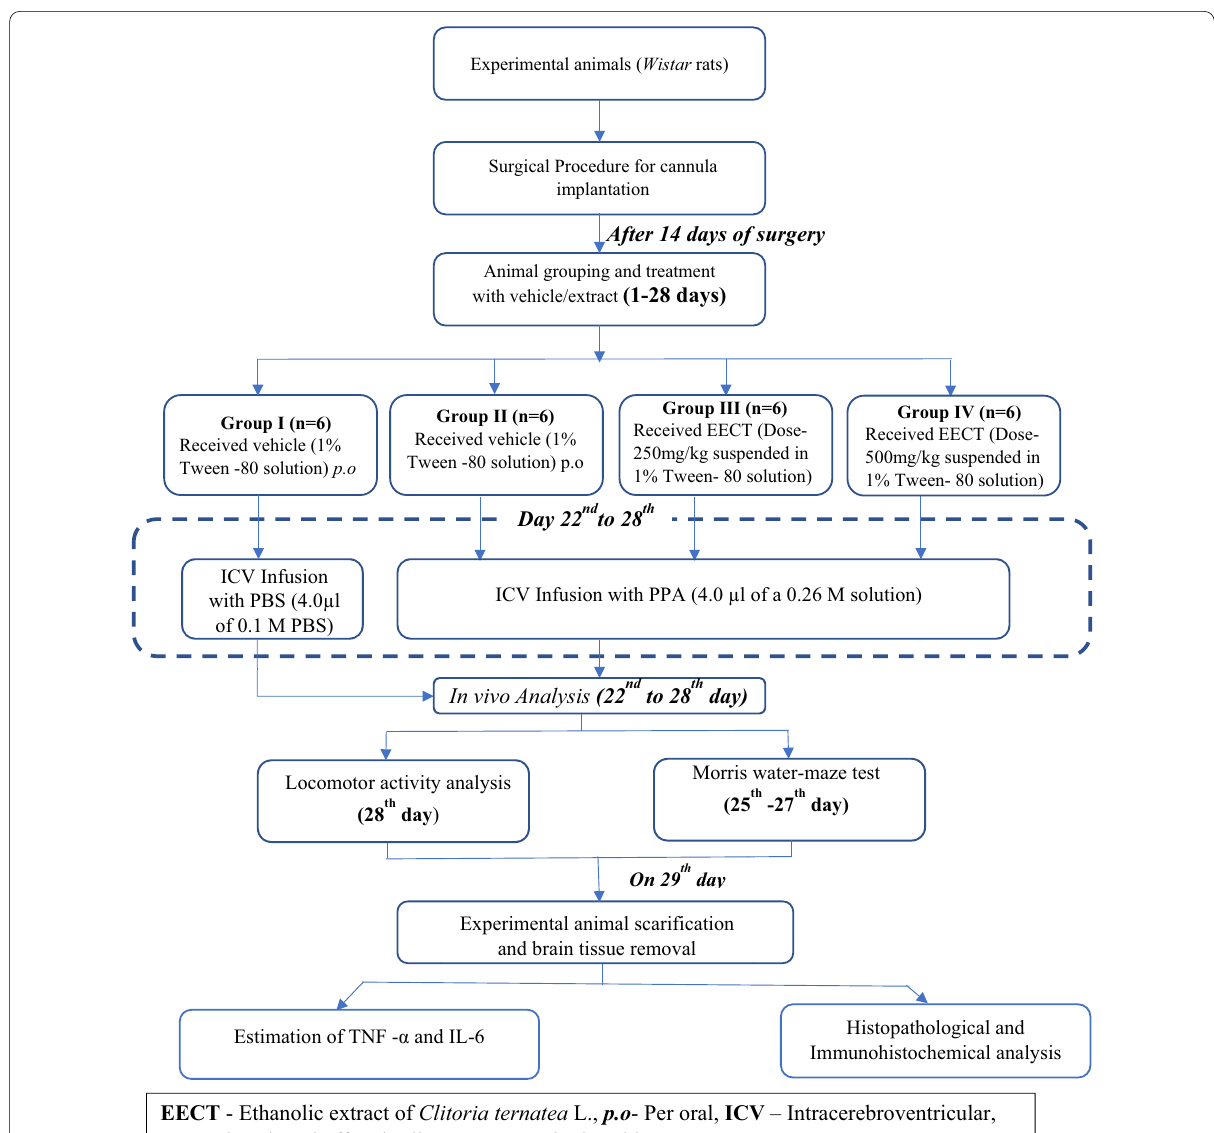
Fig. 1 Schematic diagram of the experimental